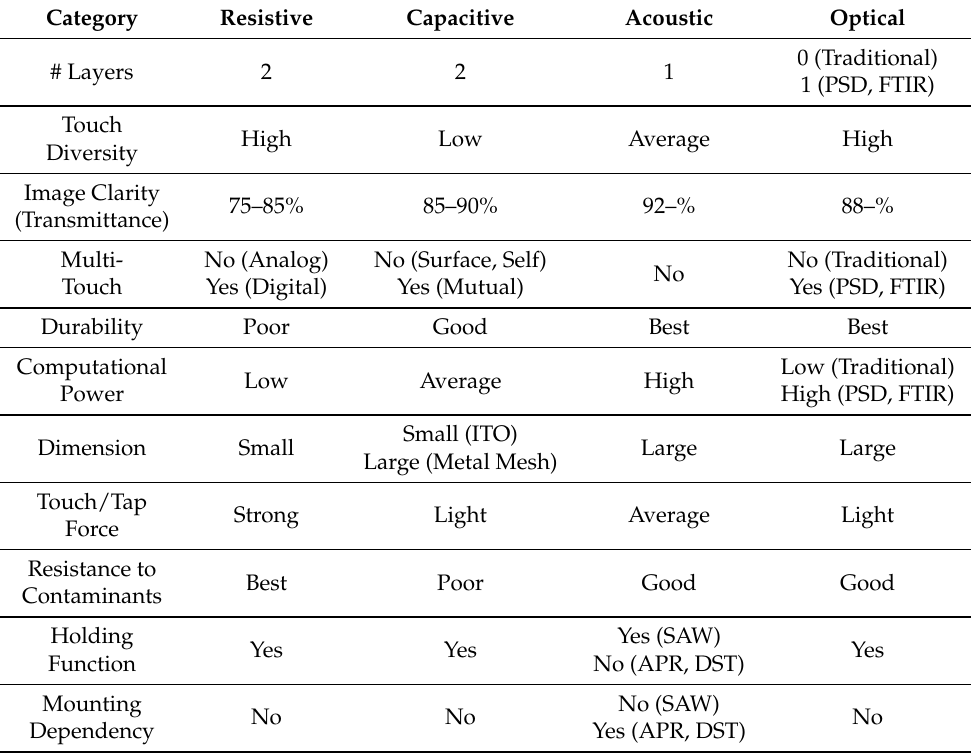
Figure 1. Categories of touchscreen technologies. This figure excludes the touchscreen techniques embedded in pixel areas in a display panel. Table 1. Comparisons of touchscreen